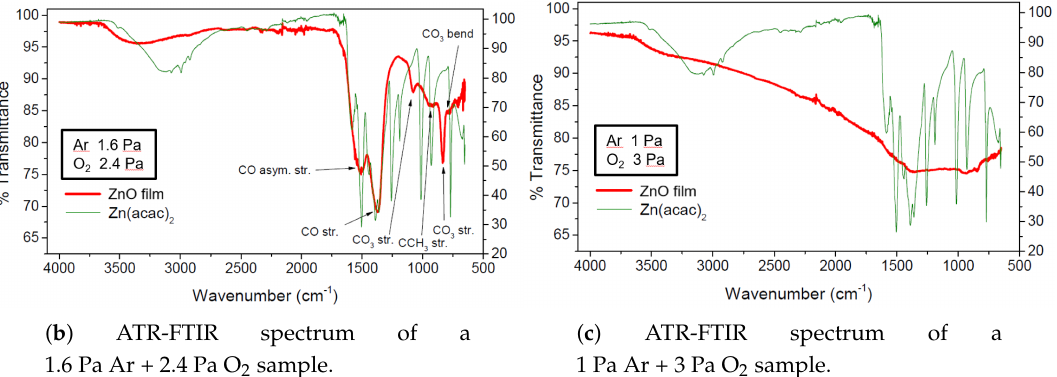
Figure 10. ATR-FTIR analysis of samples deposited (in red) with different plasma compositions at 4 Pa total treatment pressure with respect to the precursor spectrum (in